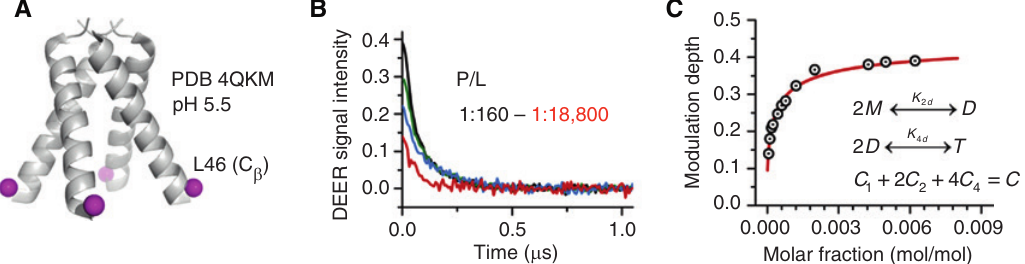
Figure 11: M2 transmembrane domain assembles via a dimer intermediate (Ref. [51]). (A) Tetramer of M2 transmembrane helices at pH 5.5. L46C residue was spin-labeled for DEER study. (B) Background-corrected DEER signals for peptide-to-lipid molar ratios (P/L) ranging from 1 : 160 to 1 : 18,800. The DEER modulation depth strongly depends on P/L in the range from 1 : 18,800 to 1 : 160. Higher order oligomers are progressively more populated as P/L increases. Only selected data are shown for clarity. (C) The fitting of DEER modulation depth values for multiple P/Ls revealed a cascade mechanism of M2TMD assembly, that is monomer(M) ↔ dimer(D) ↔ teramer(T). The equilibrium constants for the 2M ↔ D and 2D ↔ T were obtained. In the figure, C respectively. All data shown are at pH